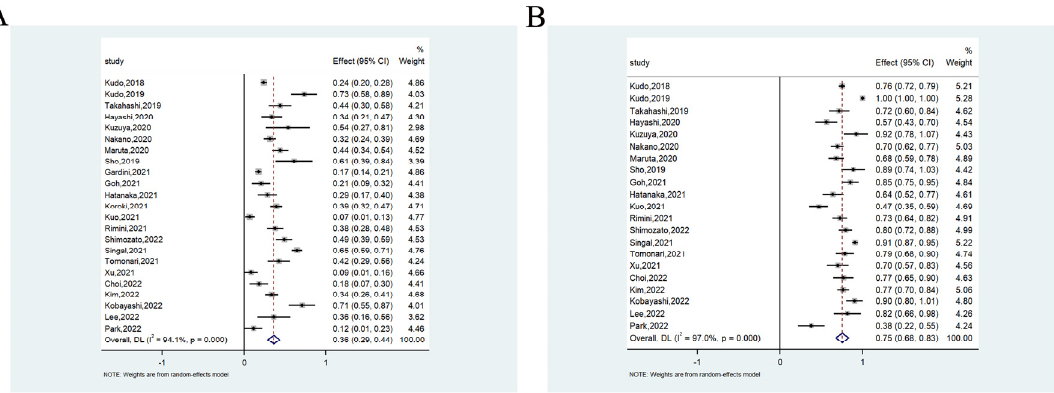
Figure 4. The ORR ( A ) and DCR ( B ) of lenvatinib for unresectable hepatocellular carcinoma.